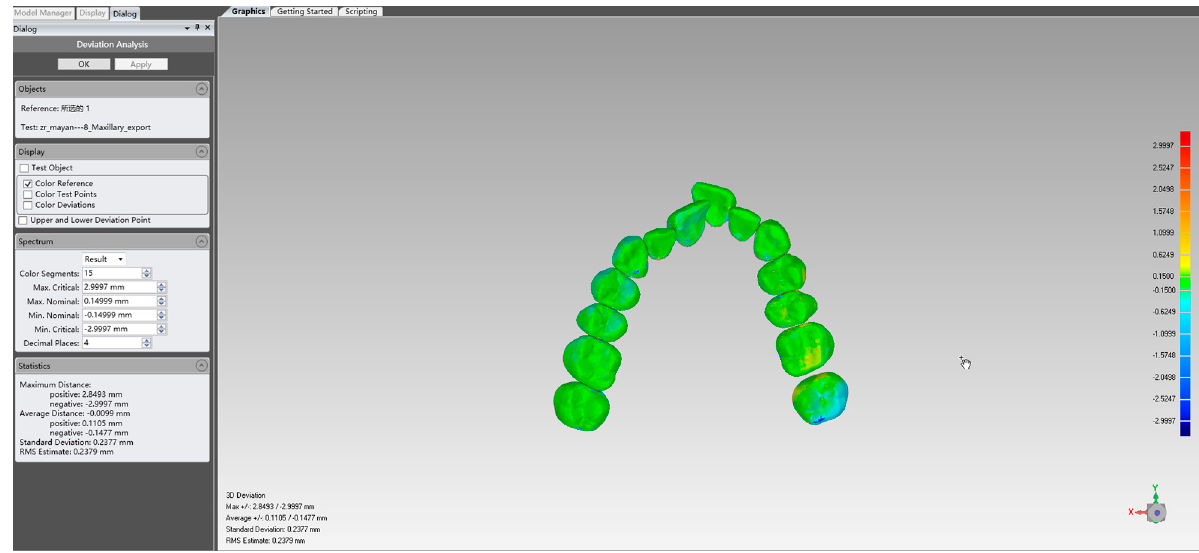
Figure 4. Shell-to-shell deviation of OTM by using a whole surface best fit algorithm and colour-mapping methods in the GEOMAGIC studio software. Green represents no deviation; red represents a large and positive deviation; blue represents a small and negative deviation. The bigger the deviation is the more OTM stray from the